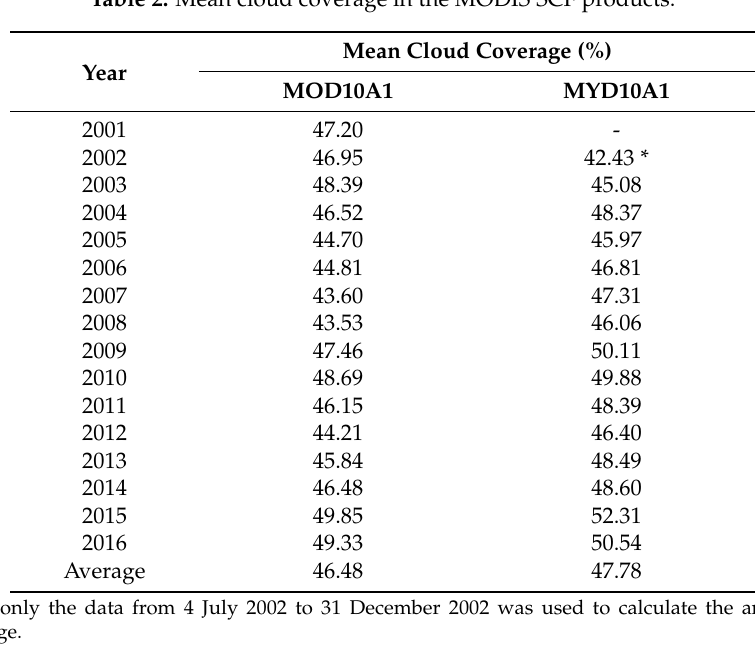
Figure 6. Annual average cloud coverage of MODIS Terra SCF product in different elevation zones. 4.2. The Effectiveness of Gap-Filling Methodology The proposed gap-filling methodology generated almost continuous spatio-temporal daily MODIS SCF products, leaving only 0.52% of cloud gaps on long-term average. The maximum gaps remaining is 5.92%. The mean cloud coverage remaining in different elevation zones after the execution of each gap-filling step is presented in Figure 7. We found an extremely consistent change trend between the single year of 2004 and the average after 16 years. Similar conditions were found in other years, which will not be explored here. MOYD, ATF, and NSTF reduced cloud cover by an average of 8.19% (compared to the original Terra data) or 9.72% (compared to the original Aqua data), 21.4%, and 16.43%, respectively.